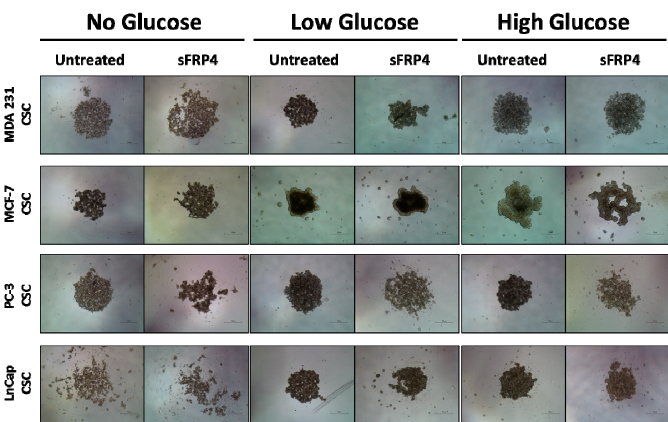
Figure 1. Effect of Secreted Frizzled Related Protein-4 on Cancer Stem Cells morphology: CSCs were isolated from breast and prostate tumour cell lines with increasing glucose concentrations and treated with sFRP4 (250 pg). The sFRP4 treatment results in disruption of the CSC sphere. (Scale bar: 100 µ m). Images are representative of all the experiments.